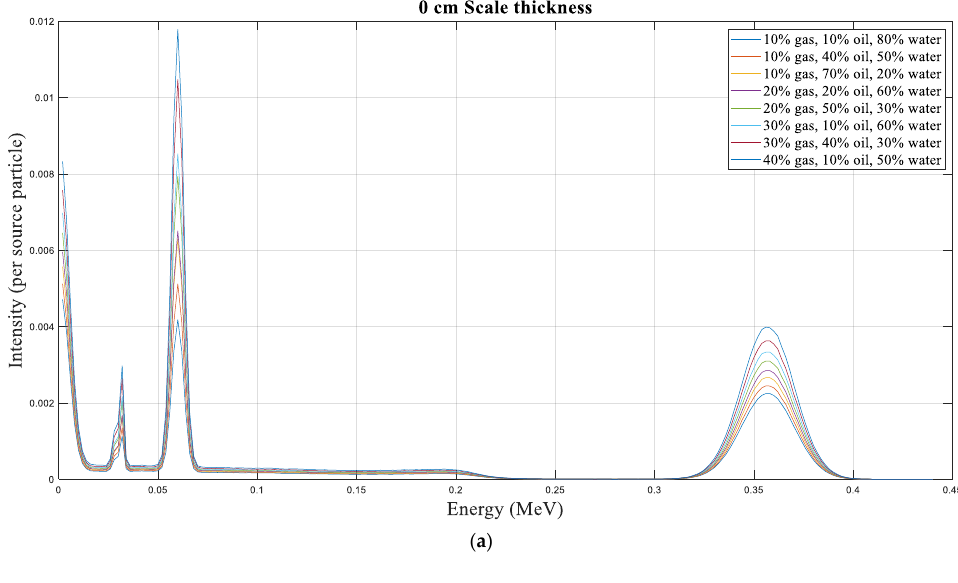
( b ) Figure 2. Spectrum received by sodium iodide detector for scale thickness of ( a ) 0 cm and ( b ) 1.5 cm. LamberteBeer’s law is used to determine the attenuation rate when a narrow gamma ray strikes an object. 𝐼 = 𝐼 0 𝑒 −𝜇𝜌𝑥 (1) 𝐼 , 𝐼 0 , 𝜇 and 𝜌 denote the intensity of un-collided, the original photons, the mass at- tenuation coefficient, and the material density of the absorber, respectively. X denotes how far the beam travels through the absorber. Equation (1) states that different objects respond to gamma radiation in different ways. This variation in behavior determines the kind and amount of a substance in the environment. A 2.54 cm × 2.54 cm NaI detector was used in this research to capture the photons that were transmitted. The detector was used to record photon energy spectra using pulse height tally (Tally F8). Previous analyses have supported the study ’ s reproductive outcomes [6]. Several research laboratory structures were used in this review, and the results from the MCNP code were compared with them.